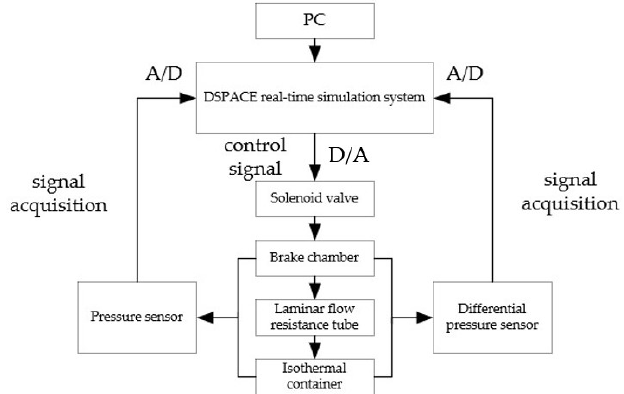
Figure 16. Overall structure of the brake pressure change rate measurement test platform.